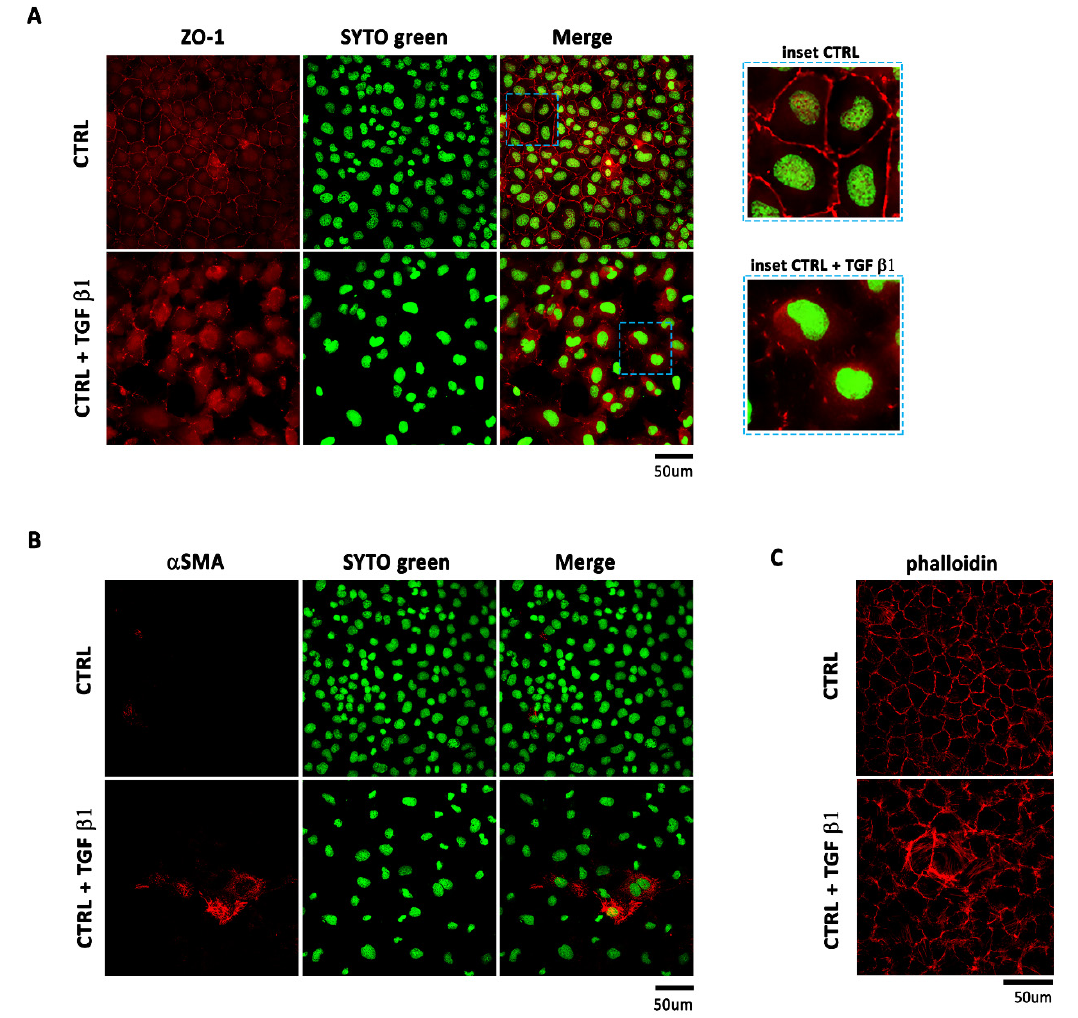
Figure 2. TGF β 1 treatment induces loss of epithelial character and acquisition of mesenchymal character in EMCs . Non-confluent EMC cultures were stimulated with TGF β 1 (1 ng/mL) and examined after 48 h by immunofluorescence for ( A ) the epithelial marker ZO-1 (inset: magnified version) and ( B ) the mesenchymal marker α SMA. Left panel: red fluorescence indicates ZO-1 or α SMA. Central panel: green fluorescence indicates SYTO Green Fluorescent staining of nuclei. Right panel: merge of both images. Scale Bar: 50 µ m. After 48 h stimulation with TGF β 1, ( C ) phalloidin visualized the increase in actin filaments.